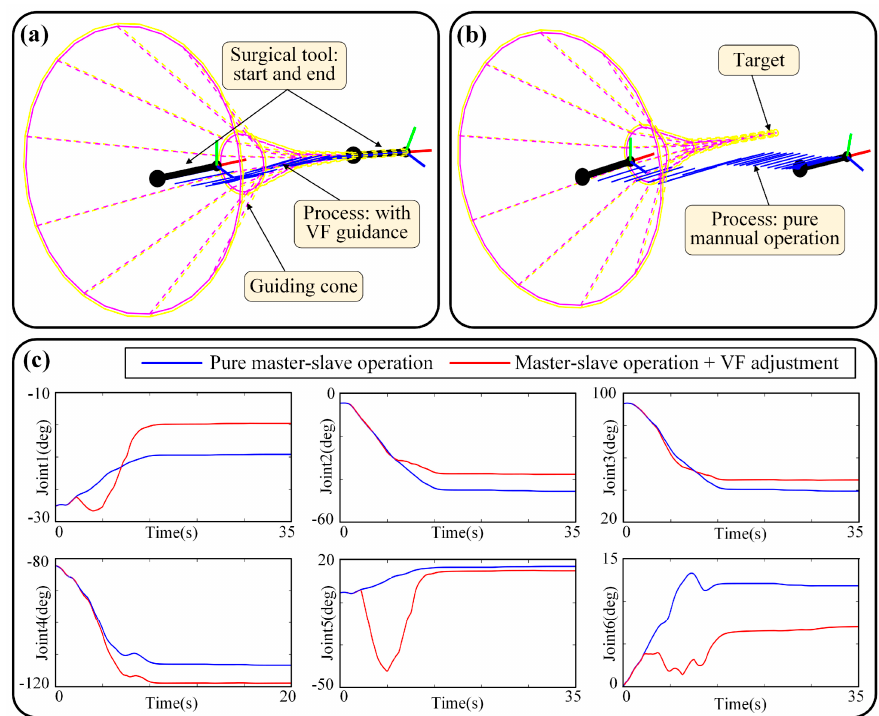
Figure 15. Simulation of “static and manual” feeding: ( a ) Motion process when VF is activated, and the target is reached; ( b ) Motion process when VF is deactivated, which is pure master–slave motion, and the target is missed; ( c ) Angle–time curves of joint space.